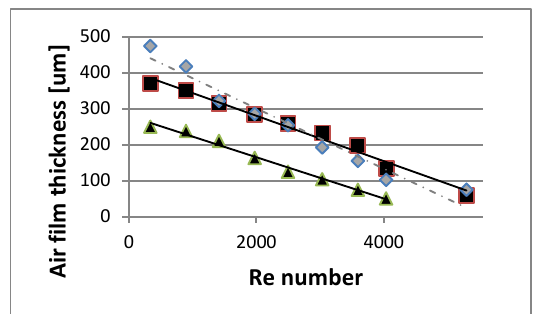
Fig. 5 The graph: air film thickness dependant on Re number. [3]